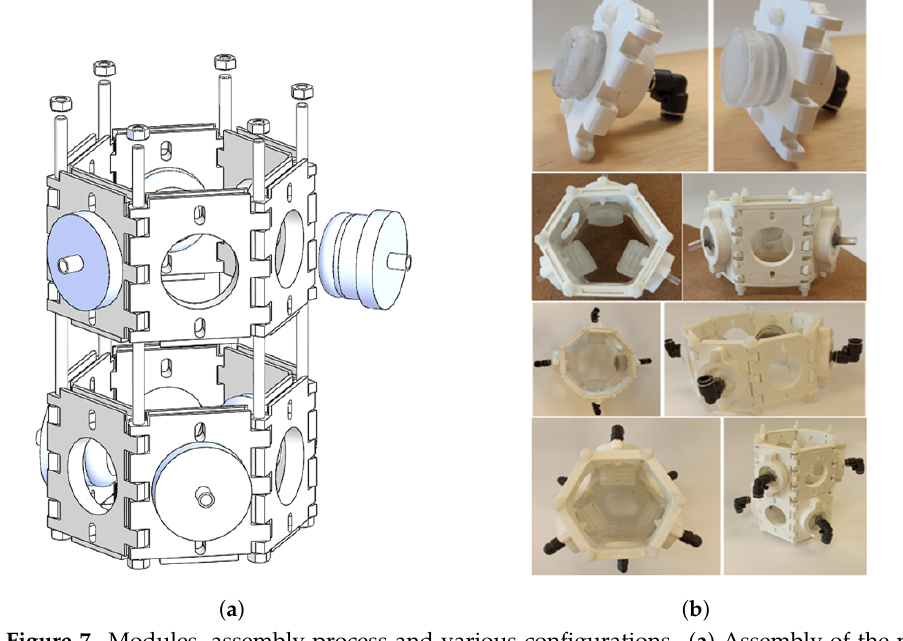
Figure 7. Modules, assembly process and various configurations. ( a ) Assembly of the modules. ( b ) Fully assembled modules and several soft grippers configurations.